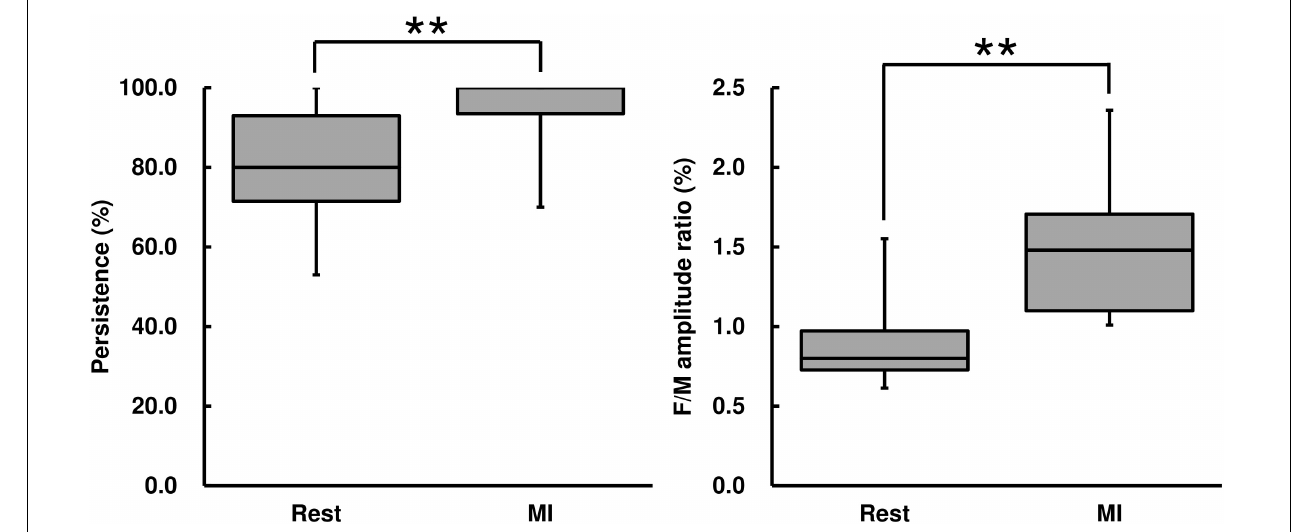
FIGURE 4 | F-wave persistence and the F/M amplitude ratio for the MI task. F-wave persistence and the F/M amplitude ratio are represented using a box and whisker plot, with the median shown as the middle horizontal line, the upper and lower quartiles indicated as boxes, and the maximum and minimum represented as whiskers. The vertical axis shows F-wave persistence (%) and the F/M amplitude ratio (%), and the horizontal axis shows the specific trial (Rest and MI). ** p < 0.01.